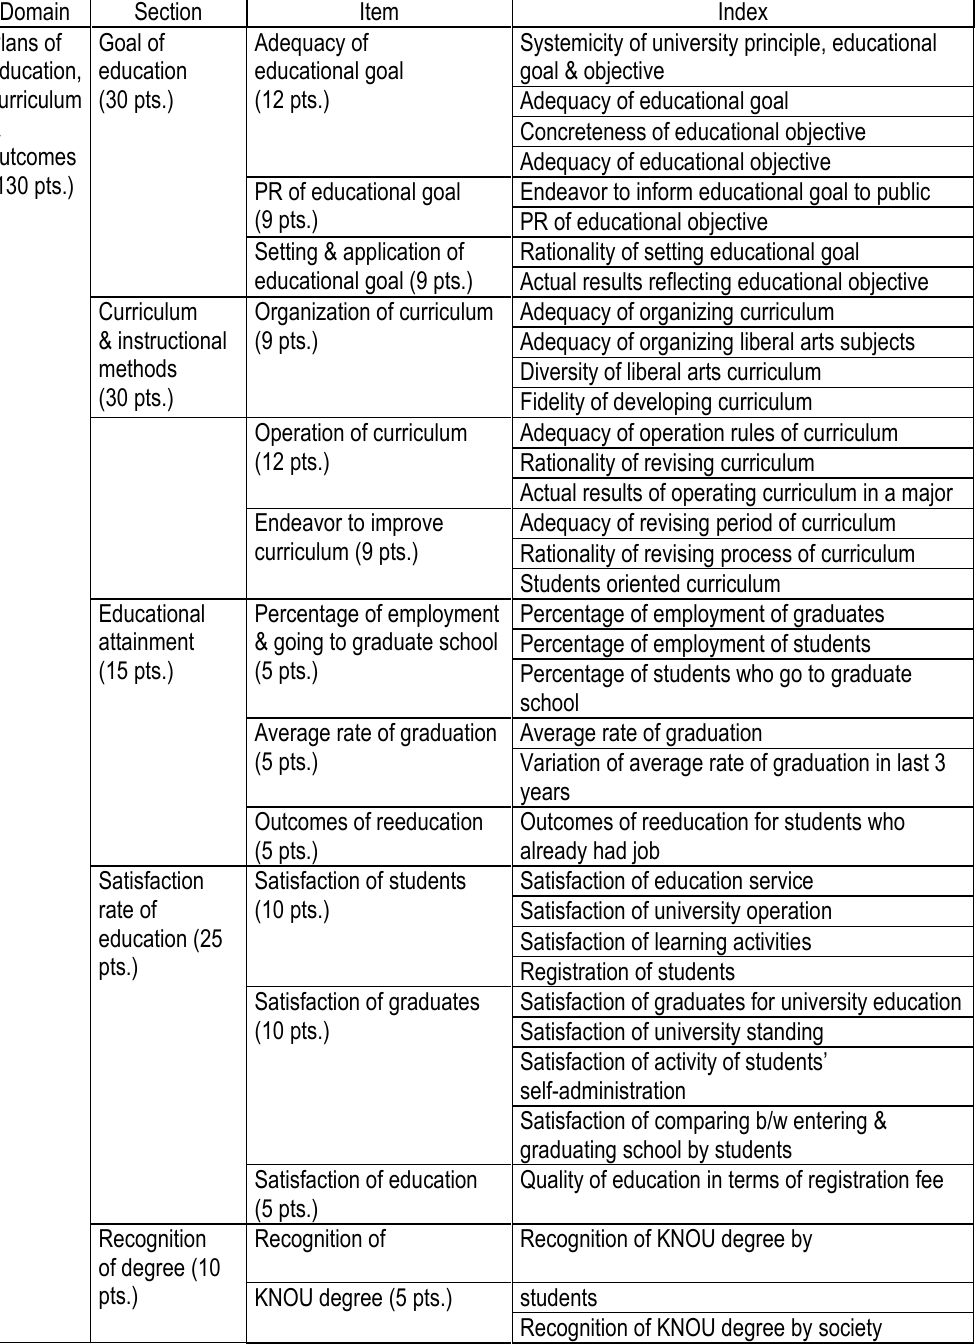
Table 2. Plans of education, curriculum and outcomes